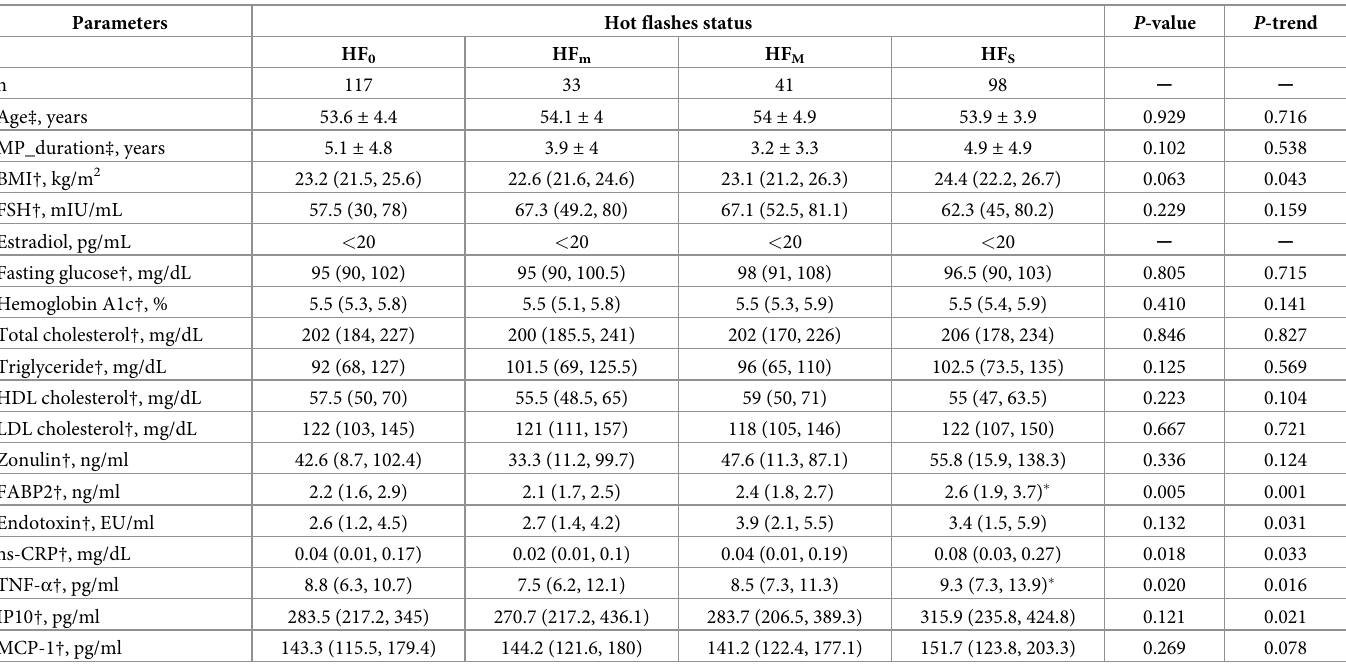
Table 1. Characteristics of the participants according to hot flashes